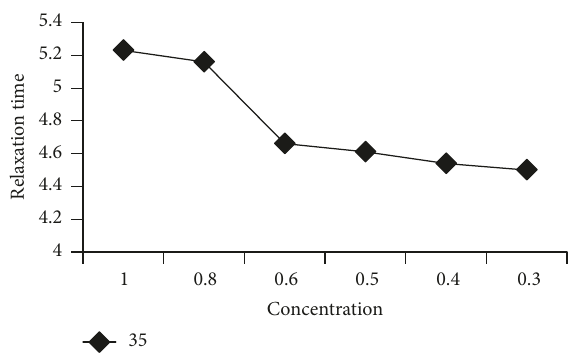
Figure6:Variationofintermolecularfreelengthwithconcentration at 35 ∘ C temperature.